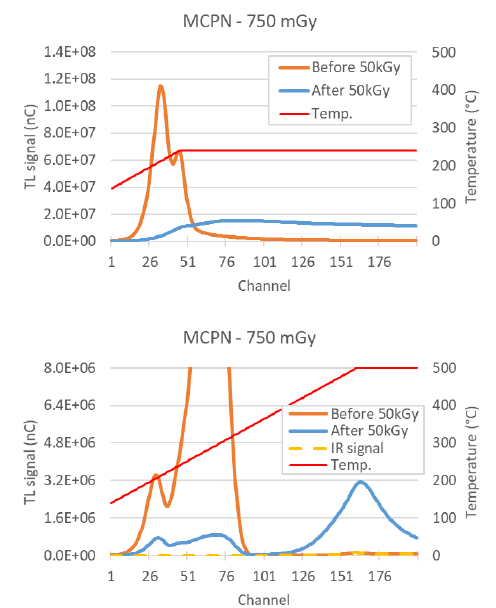
Fig. 6. Luminescence curves MCPN TLDs before and after 50 kGy exposure. Measurement after a 750 mGy irradiation in front of a 60 Co source. Top: constructor readout protocol, bottom: test readout protocol.